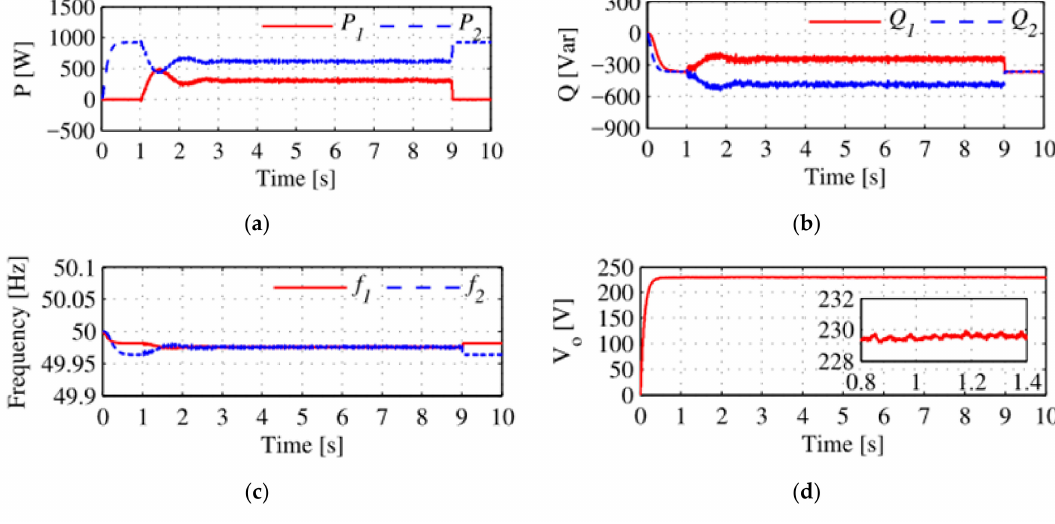
Figure 10. Power sharing in the first scenario considering complex (R-L) feeder impedance; ( a ) output active powers of DGs, ( b ) output reactive powers of DGs, ( c ) output frequencies of DGs, ( d ) terminal DGs